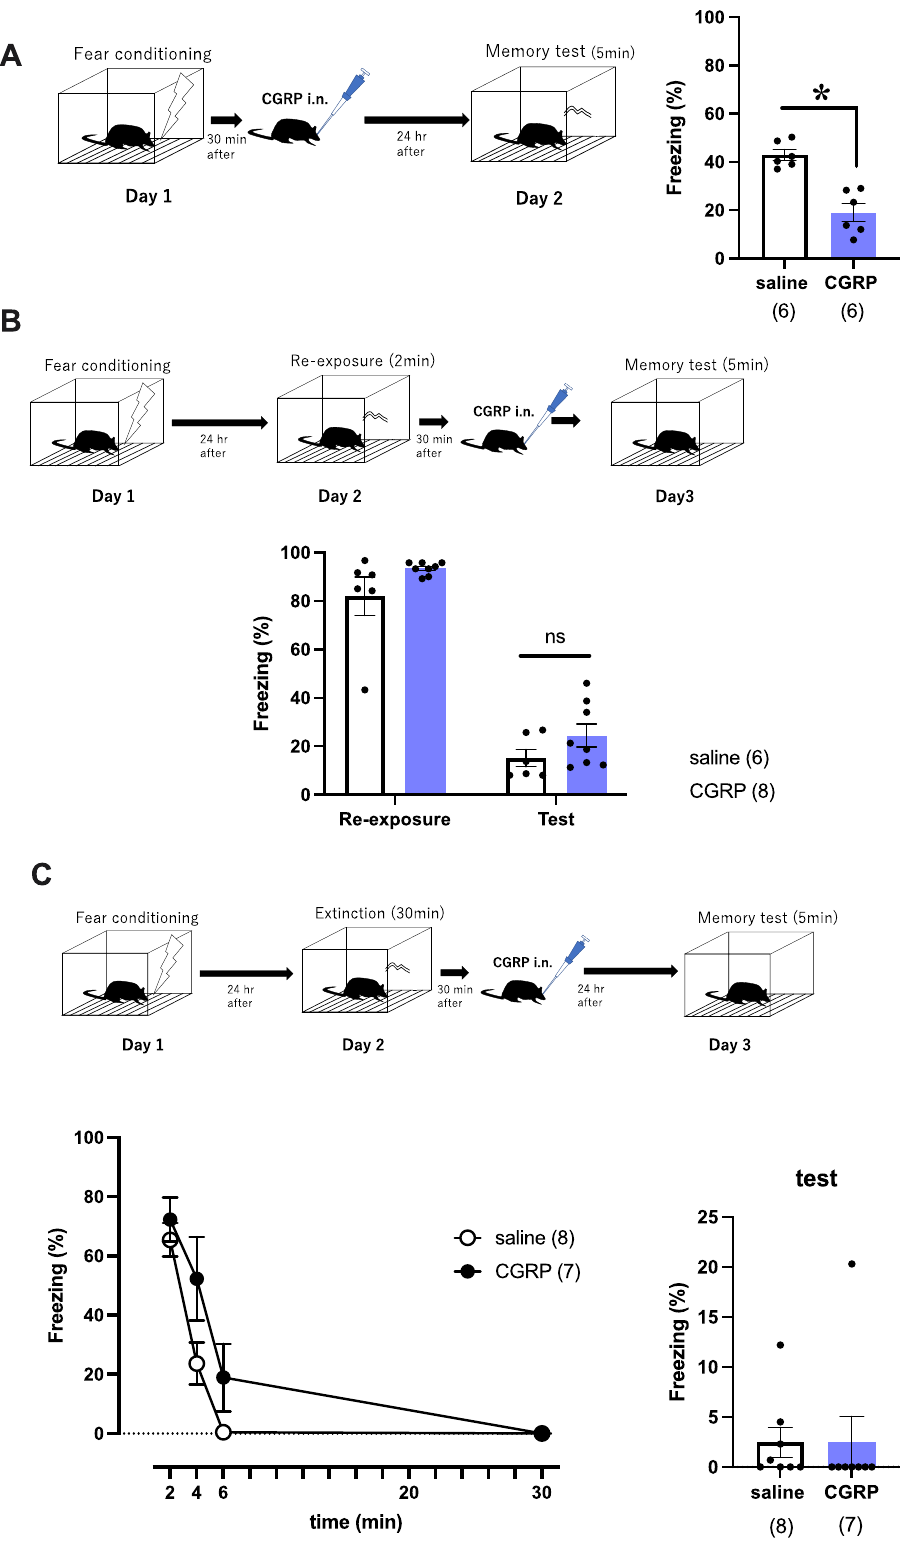
Figure 2. Effects of intranasal CGRP on contextual fear memory. ( A ) To study the effect of CGRP on memory retention of contextual fear, CGRP was nasally administered 30 min after fear conditioning, and freezing behavior was observed 24 h later. ( B ) To investigate the effect of CGRP on the reconsolidation of contextual fear memory, mice were fear conditioned and re-exposed 24 h later for 2 min. CGRP was administered intranasally 30 min after re-exposure, and freezing behavior was observed on Day 3. ( C ) For fear memory extinction, mice were fear conditioned and 24 h later were placed back in the box for 30 min for extinction of the of contextual fear memory. CGRP was administered intranasally 30 min after the 30-min extinction, and freezing behavior was observed on Day 3. Each bar indicates the mean ± S.E.M. * p < 0.05, Welch’s t test. Numbers in parentheses indicate the number of animals in each